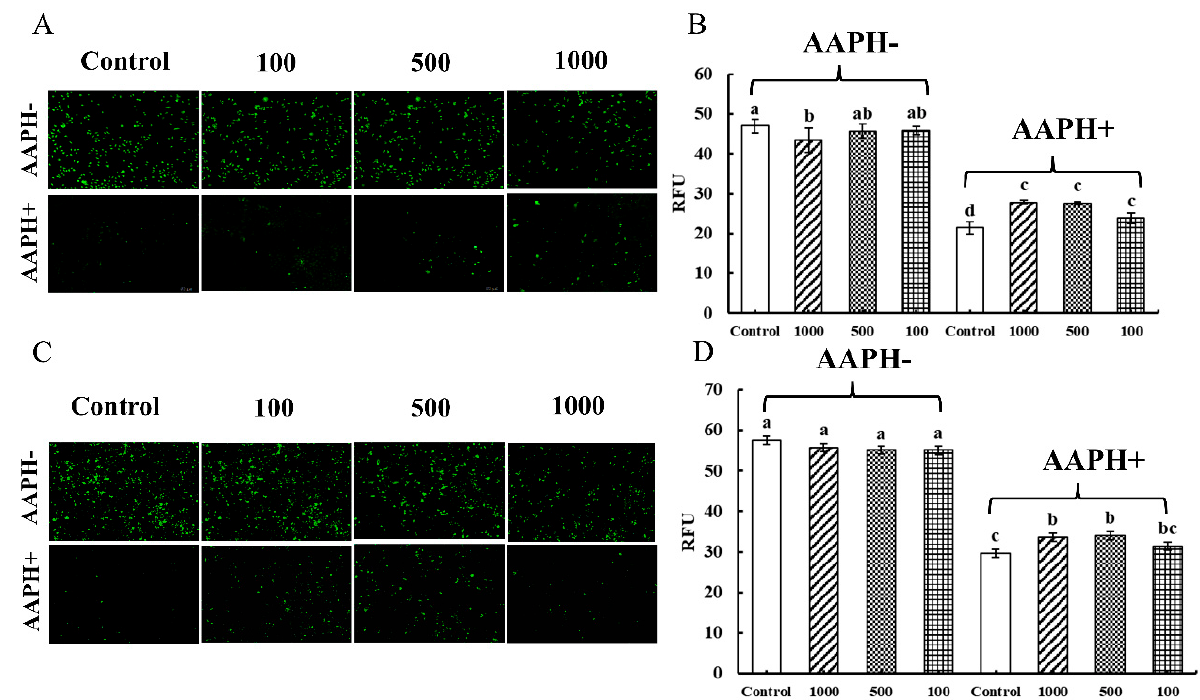
Figure 5. Determination of membrane potential in Caco-2 cells and Raw 264.7 cells. The effect of the CNPs at different concentrations on cell membrane potential in Caco-2 cells and Raw 264.7 cells are shown in ( A ) and ( B ), and in ( C ) and ( D ), respectively; different superscript letters indicate significant differences ( p < 0.05).